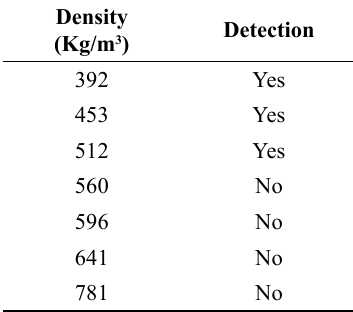
Table 4 . Ability of the Termatrac™ to detect C. brevis through 38 mm thick Pinus radiata samples of increasing